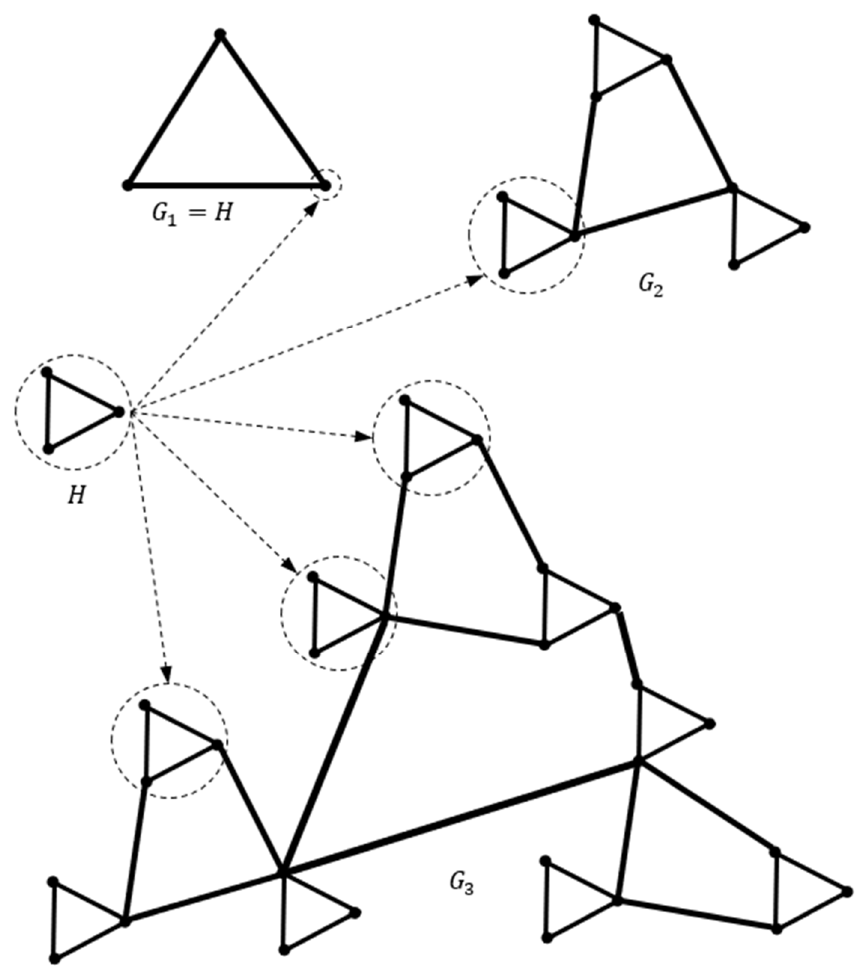
Figure 3. Trajectory 𝐺 (cid:2869) , 𝐺 (cid:2870) , 𝐺 (cid:2871) of the prefractal graph 𝐺 (cid:2871) . The dotted circles indicate the